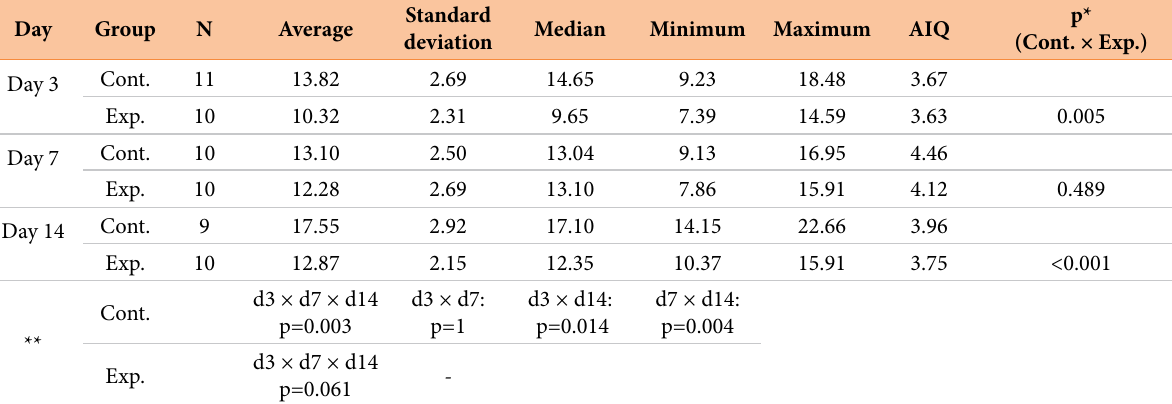
Table 8 - Average area occupied by collagen III, using picrosirius-red